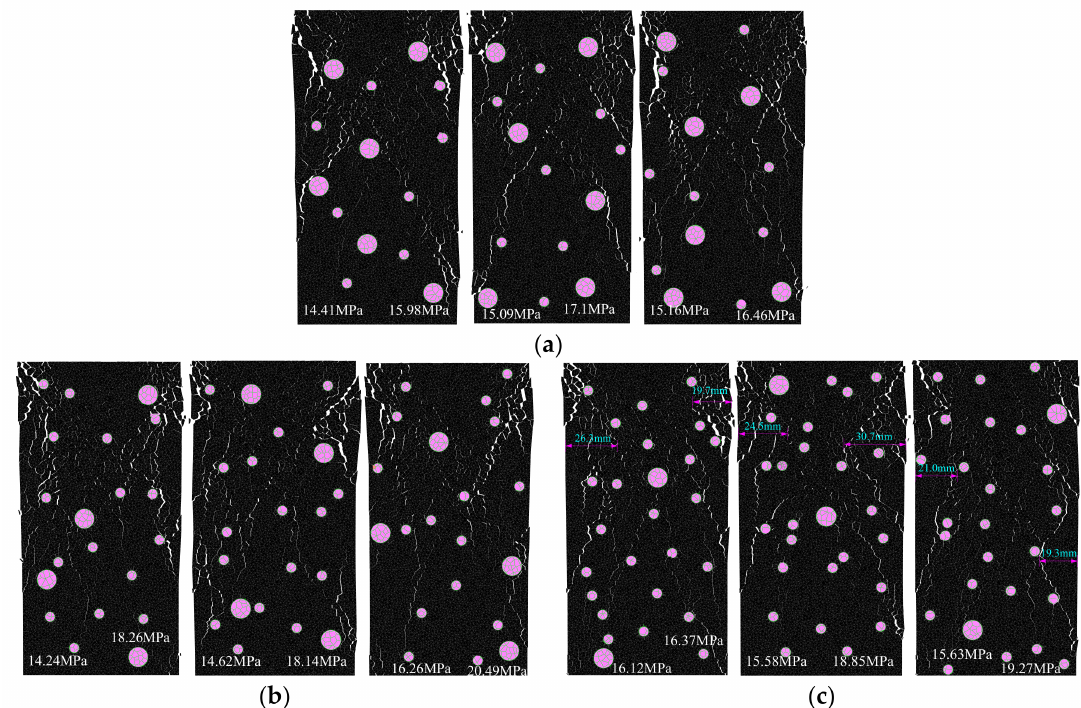
Figure 22. Crack patterns of proportions of different size minerals with the same mineral ratio (4.9%) after sample is broken: ( a ) P1–P3: 6:2; ( b ) P4–P6: 4:4; ( c ) P7–P9: